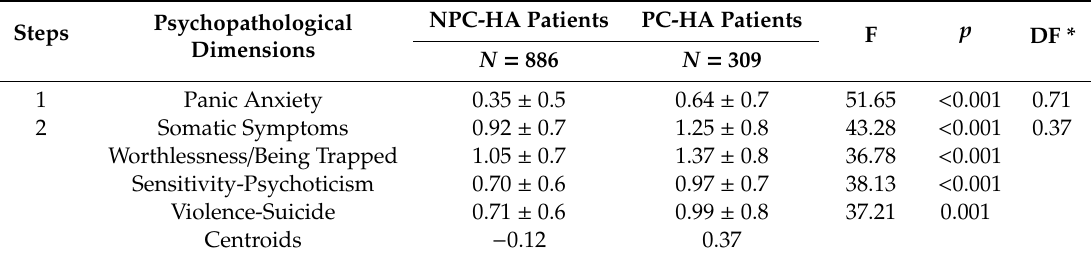
Table 2. Di ff erences in severity of psychopathological symptoms between opioid dependent subjects with (PC) and without (NPC) ascertained lifetime psychiatric problems at TC treatment onset: stepwise discriminant